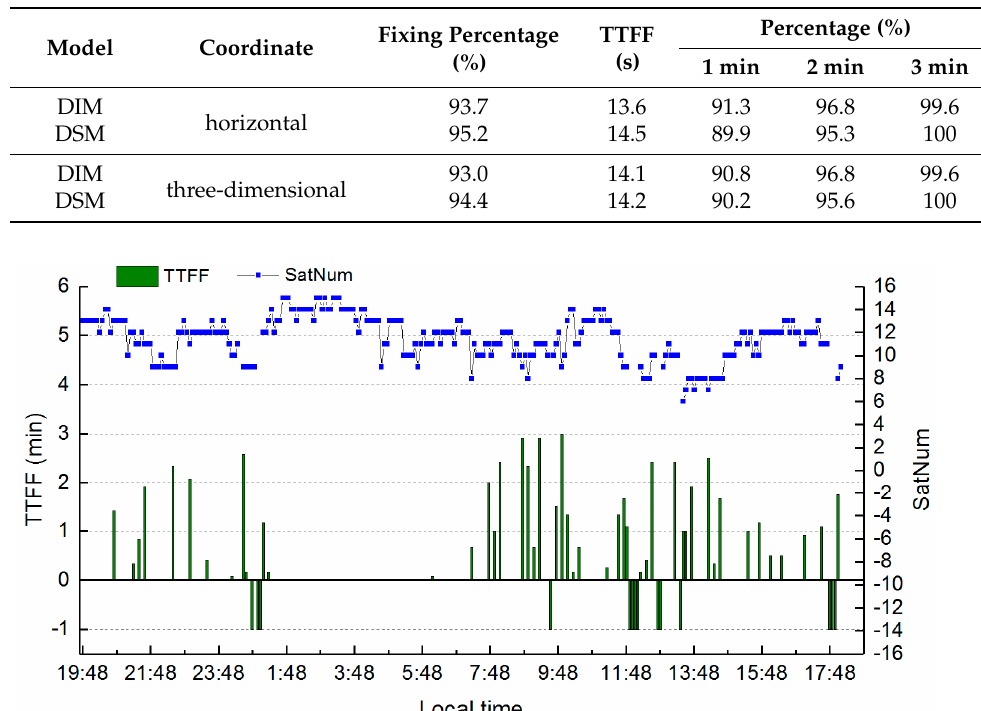
Figure 4. Time series of TTFF and satellite numbers with participating ambiguity-fixed satellites.